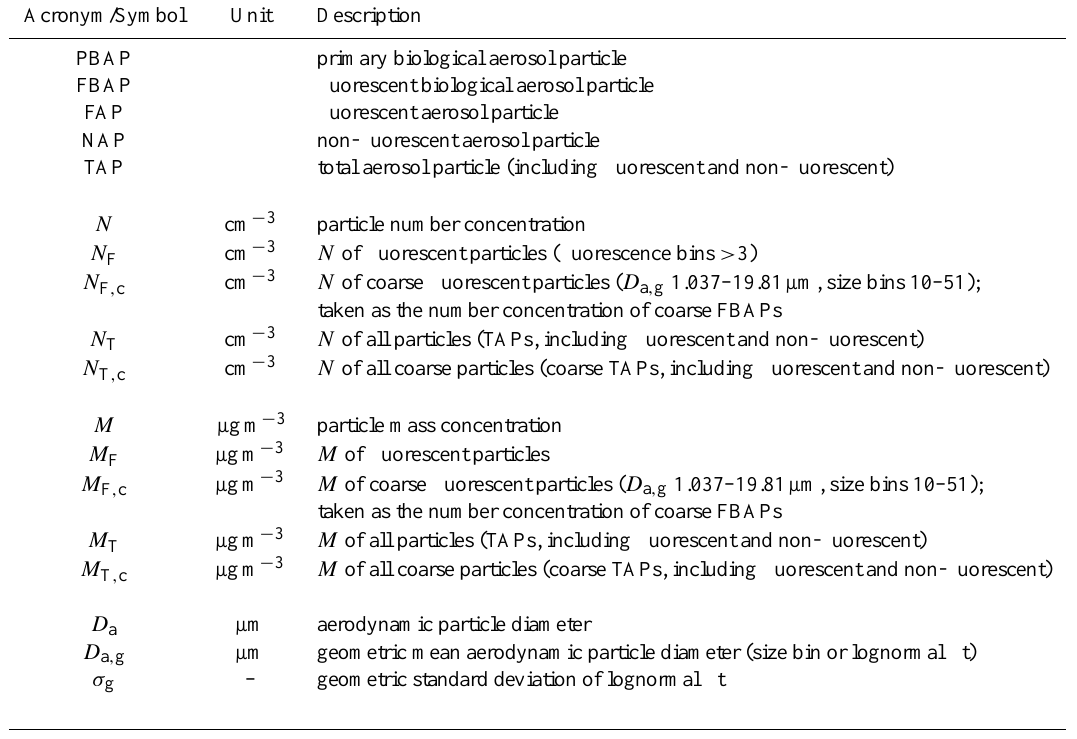
Table A1. List of frequently used acronyms and